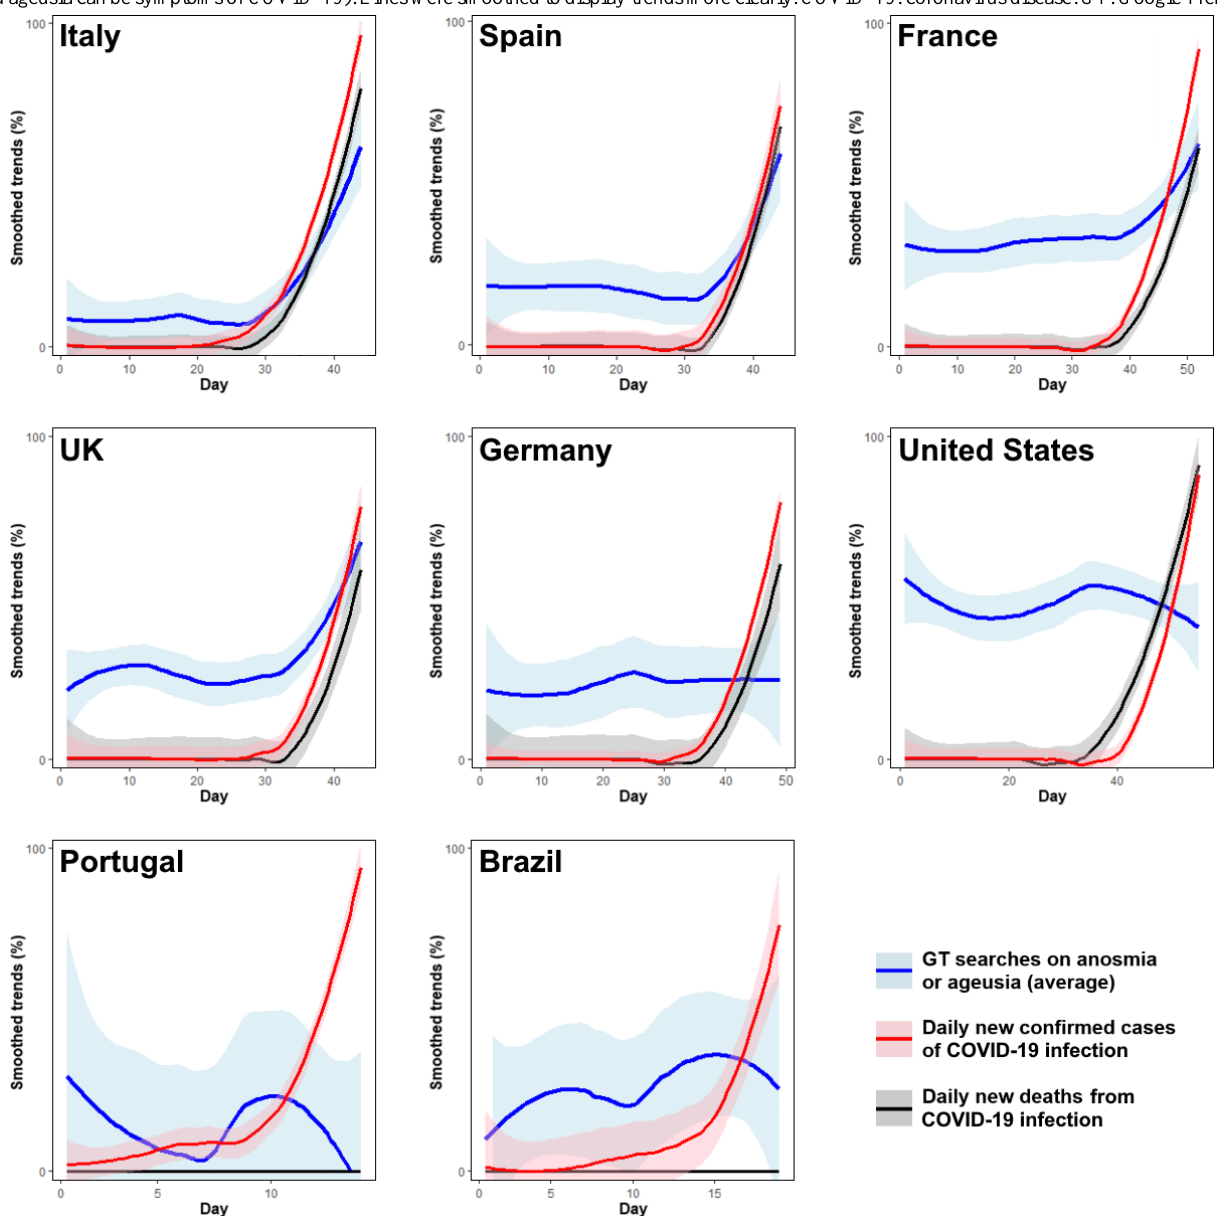
Figure 3. Average GT data for anosmia and ageusia and relative frequency of new COVID-19 infections and deaths. Data are presented as Loess-smoothed percentages of the maximum value (smoothed trends) on a daily basis from February 1 to March 15, 2020 (before the media publicized that anosmia and ageusia can be symptoms of COVID-19). Lines were smoothed to display trends more clearly. COVID-19: coronavirus disease. GT: Google